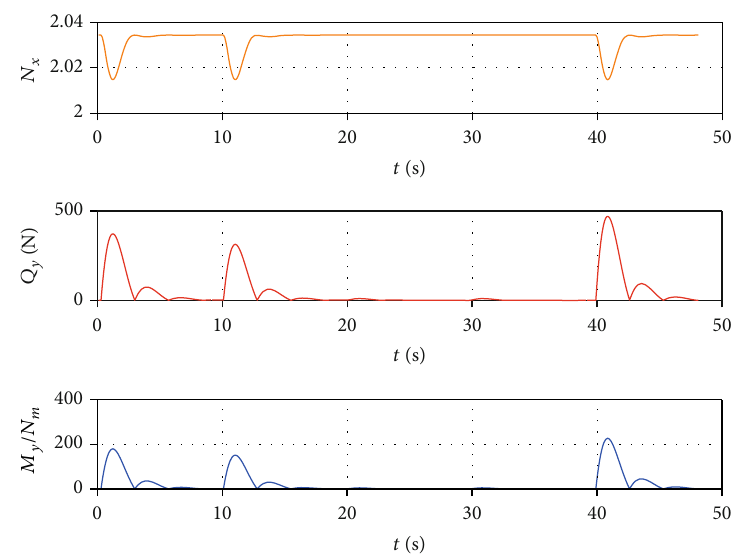
Figure 11: Time histories of the maximum axial load, shear force, and bending moment with basic